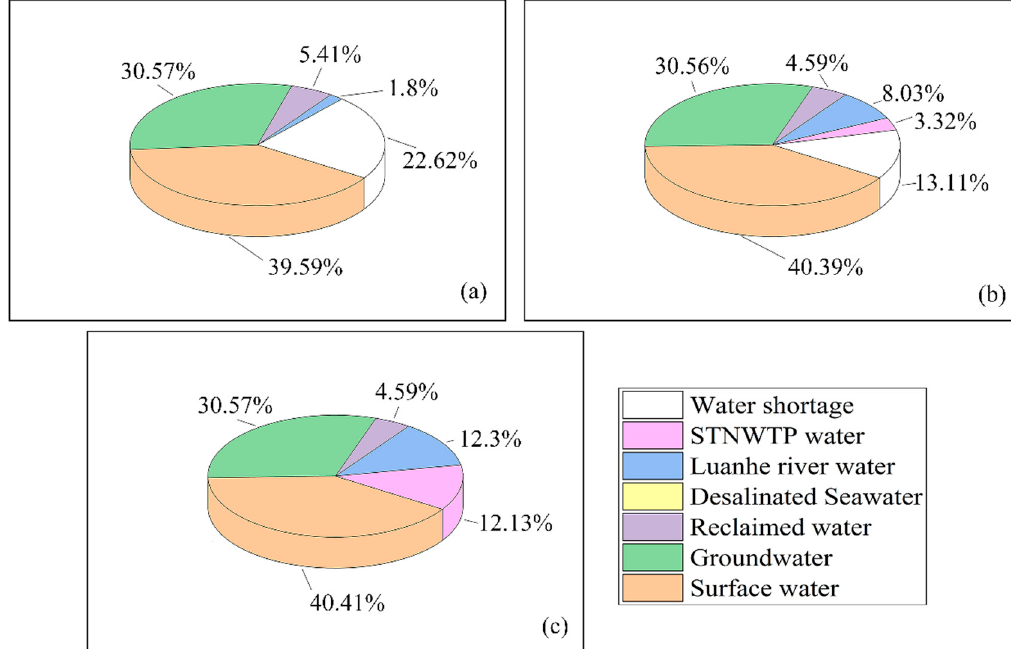
Figure 8. Distribution of water supply in suburban areas for: ( a ) (surface water 50% + Luanhe river water 75%); ( b ) (surface water 50% + Luanhe river water 75% + STNWTP water 95%); ( c ) (surface water 50% + Luanhe river water 75% + STNWTP water 75%).